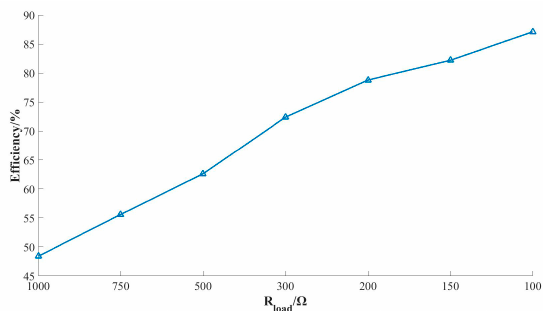
Figure 16. Curve of relationship between load and the output efficiency of the CC–CV converter.